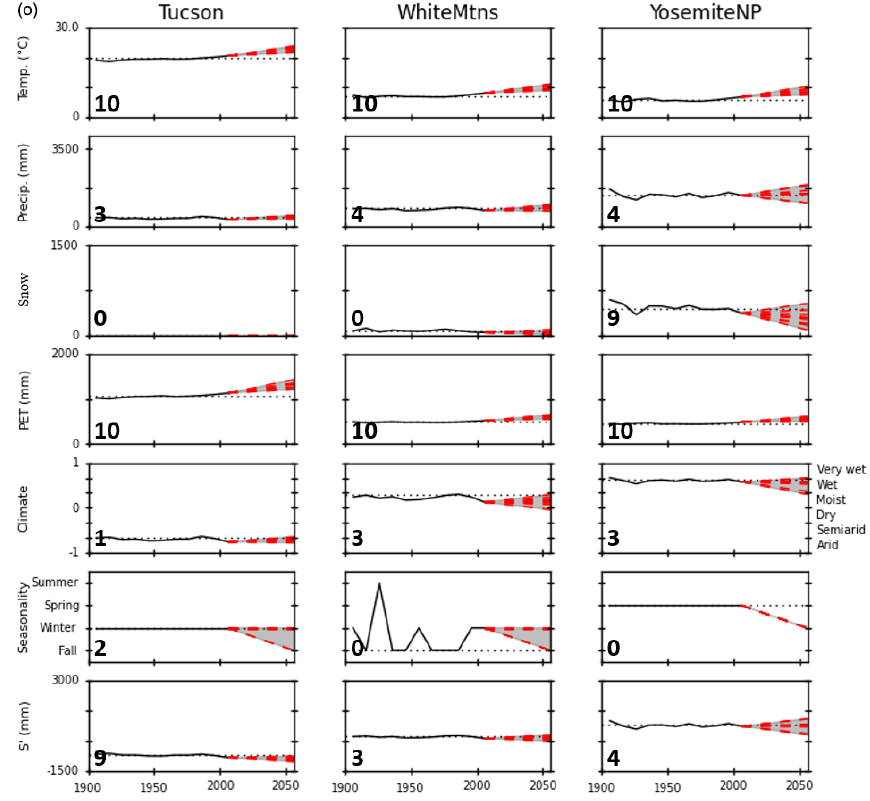
Figure A2. Time series of average decadal temperature, precipitation, snow (1 April snow water equivalent), potential evapotranspiration (PET), climate (FMI), seasonality, and available water ( S (cid:48) ) for 45 specific locations in the western U.S. For the climate/FMI figures, the FMI values range from 1 to − 1 (primary y axis on the left), whereas the categorical version of the index ranges from arid to very wet (secondary y axis on the right). Dotted black line represents the 1971–2000 base period; the dashed red line connects the 2001–2010 value to the 2041– 2070 climate projections for each of the 10 models. The gray shaded area represents the range of model projections. The number in the lower left indicates the HLVA vulnerability index for the metric and location depicted in the associated graph. Note that Oregon, Washington, and Idaho locations are displayed first in alphabetical order and are followed by those of California, Nevada, and